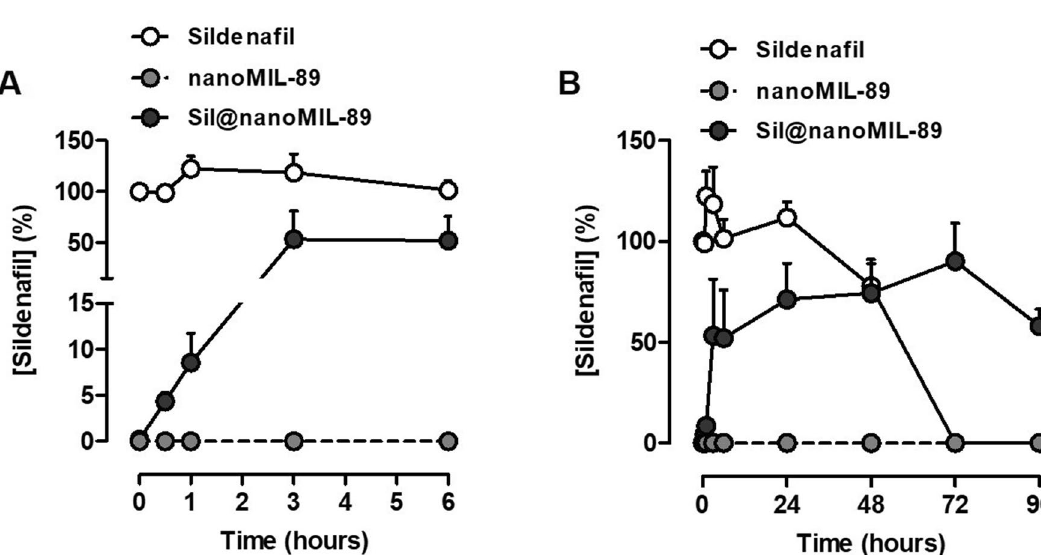
Figure 2. Sildenafil release by Sil@nanoMIL-89. Sildenafil levels in plasma were measured from incubations of Sil@nanoMIL-89 (4 mg/ml), nanoMIL-89 (4 mg/ml) and sildenafil (1 mg/ml) at 37 °C over ( A ) 6 h and ( B ) 96 h. Data are mean ± SEM for n = 6. Statistical significance was determined by two-way ANOVA followed by Tukey’s multiple comparisons test. Statistical significance was assumed where *p <